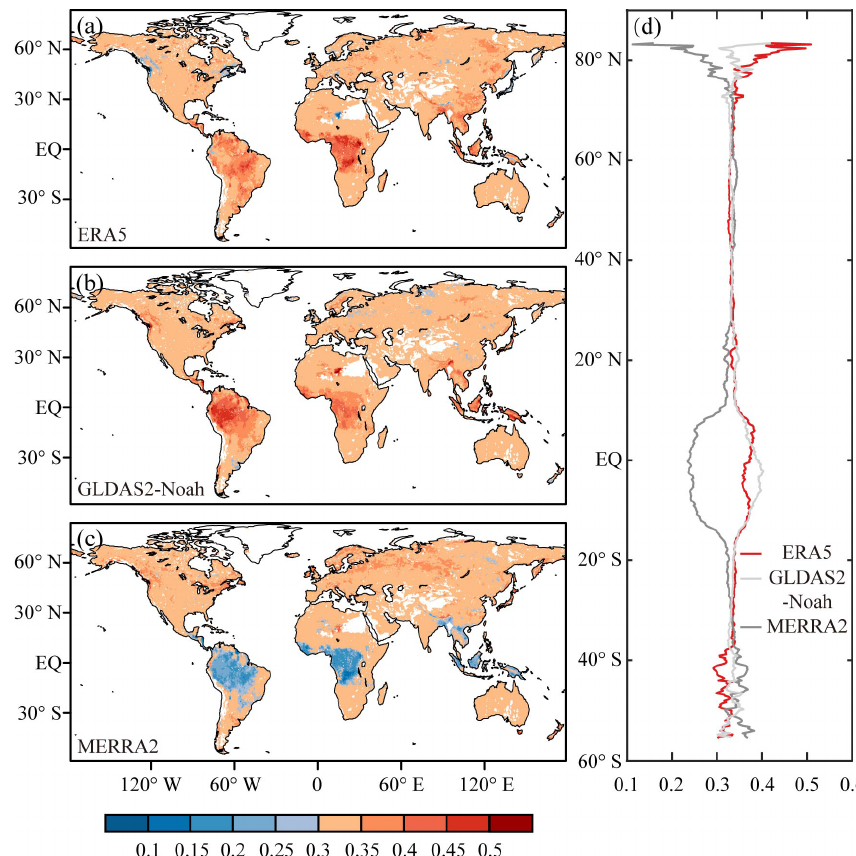
Figure 3. (a–c) Spatial distribution of weights and (d) latitudinal distribution of weights.